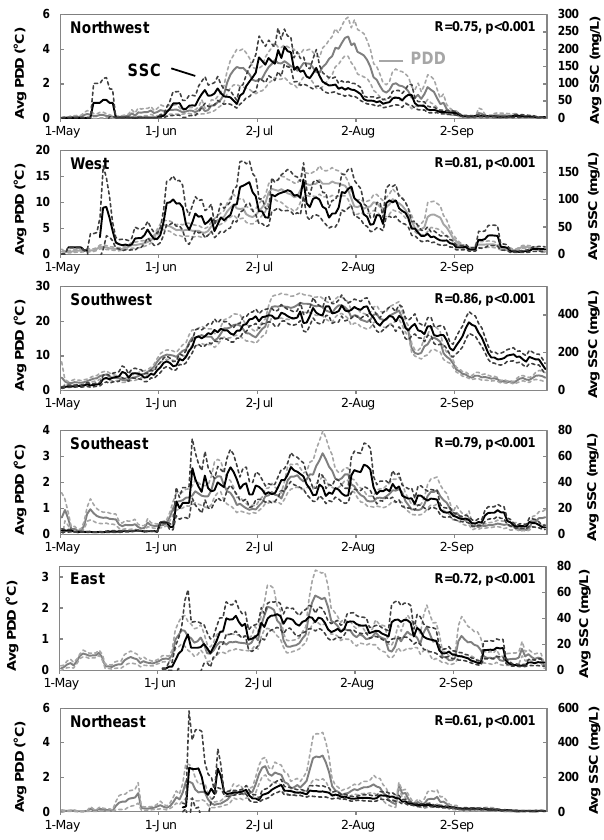
Fig. 8. Mean seasonal development of ice sheet PDD and down- stream fjord SSC for each of the six regions. A seasonal climatol- ogy is calculated by taking day-of-year averages over 2000–2009, with 95% confidence intervals. Seasonal cycles broadly coincide with plume onset coincident with or after surface melt onset, though the East and Northeast regions show difficulty detecting onset due to presence of sea ice. High SSCs persist in the Southwest region during the waning of the melt